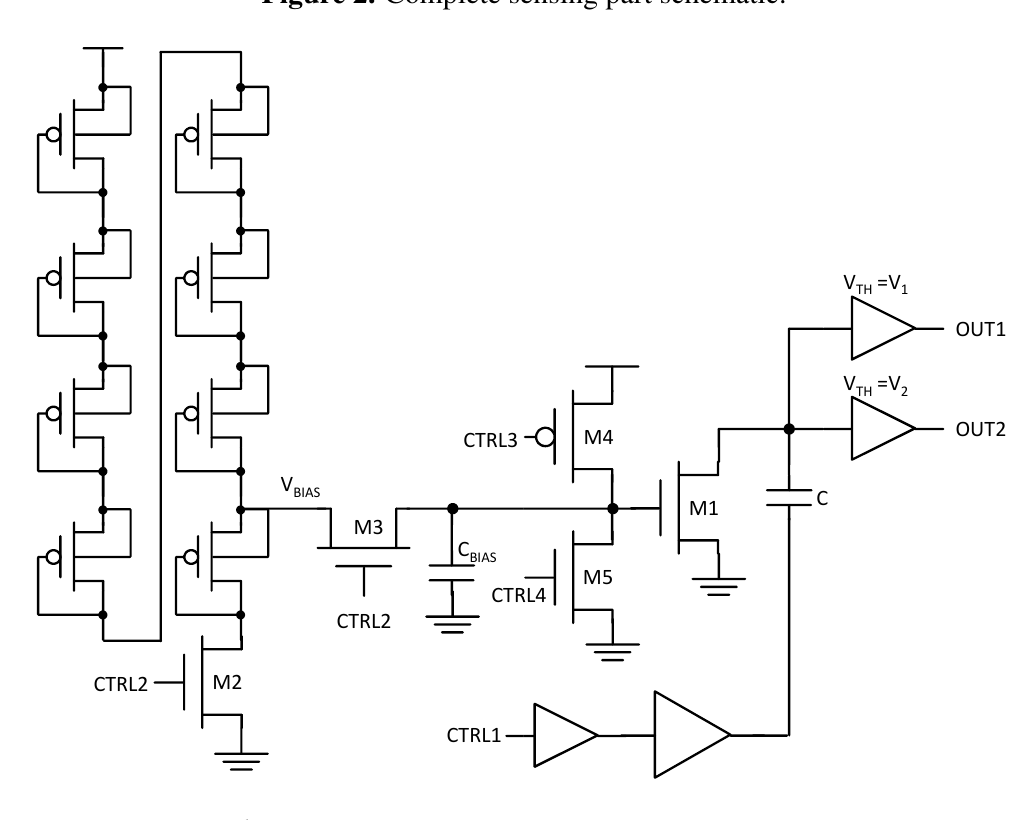
Figure 2. Complete sensing part